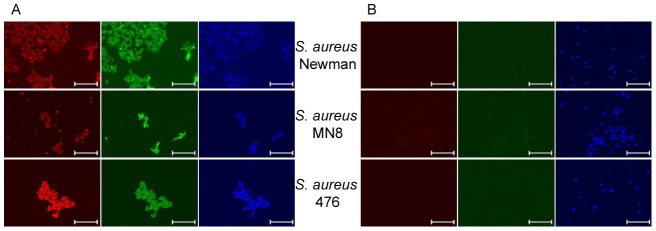
CLSM imaging of ClfA and PNAG expression by S. aureus Newman, MN8 or 476 strains.A) S. aureus labeled with mAb F598 to PNAG directly conjugated to Alexa Fluor 488 (F598-AF488), goat antibody to dPNAG−ClfA conjugate vaccine that had been previously absorbed with S. aureus Newman DU 5852 to remove antibody to dPNAG and a secondary donkey antibody to goat IgG conjugated to AF568 and the nucleic acid-specific fluorescent dye Syto 62. B) S. aureus stained with mAb F429 to P. aeruginosa alginate directly conjugated to AF488, NGS and a secondary donkey antibody to goat IgG conjugated to AF568 and Syto 62. For both panels A and B, the first, second and third columns represent S. aureus samples viewed in the red (ClfA), green (PNAG) and blue (bacterial DNA) channels, respectively. Bar = 10 µm.